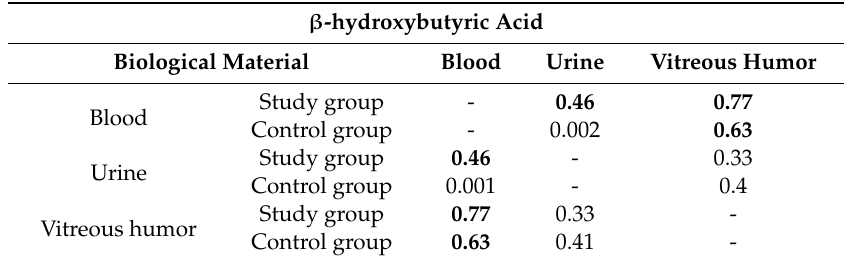
Table 12. Correlation between BHB concentration in di ff erent biological materials. Significant correlations are in bold.